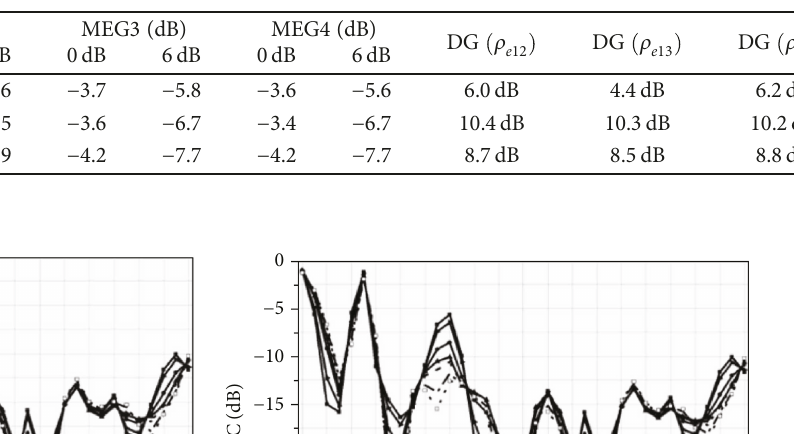
Table 2: Meg and DG of MIMO antenna system.